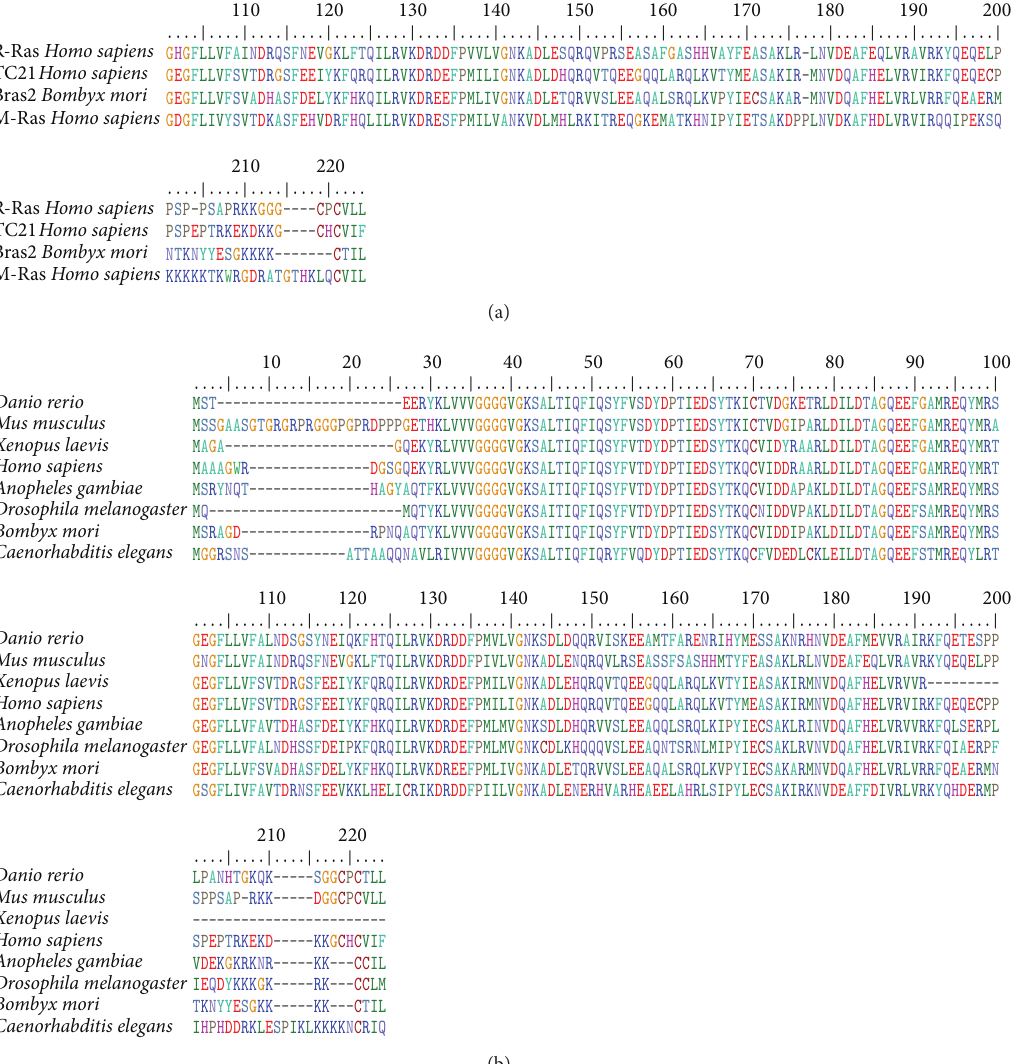
Figure 1: (a) Alignment of amino acid sequence of BmBras2 with members of the R-Ras superfamily from Homo sapiens . BmBras2 shares 69% of its amino acid identity with R-Ras, 77% with TC21 (R-Ras2) and 59% with M-Ras (R-Ras3). (b) Alignment of BmBras2 amino acid sequence with homologous proteins from different